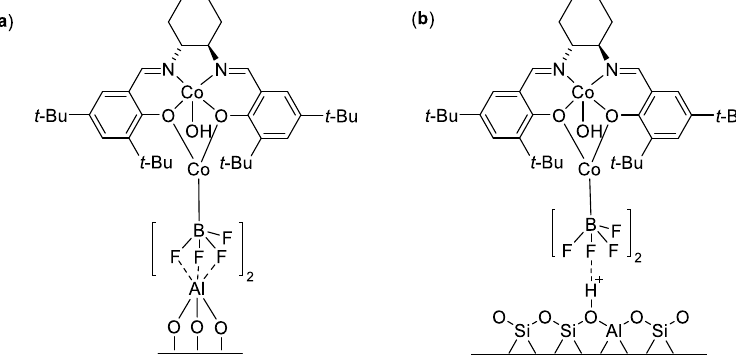
Figure 49. Al-SBA-15-supported Co–salen catalyst 126 , formed by interactions with ( a ) Lewis acidic sites and ( b ) Brønsted acidic sites. sites and ( b ) Brønsted acidic